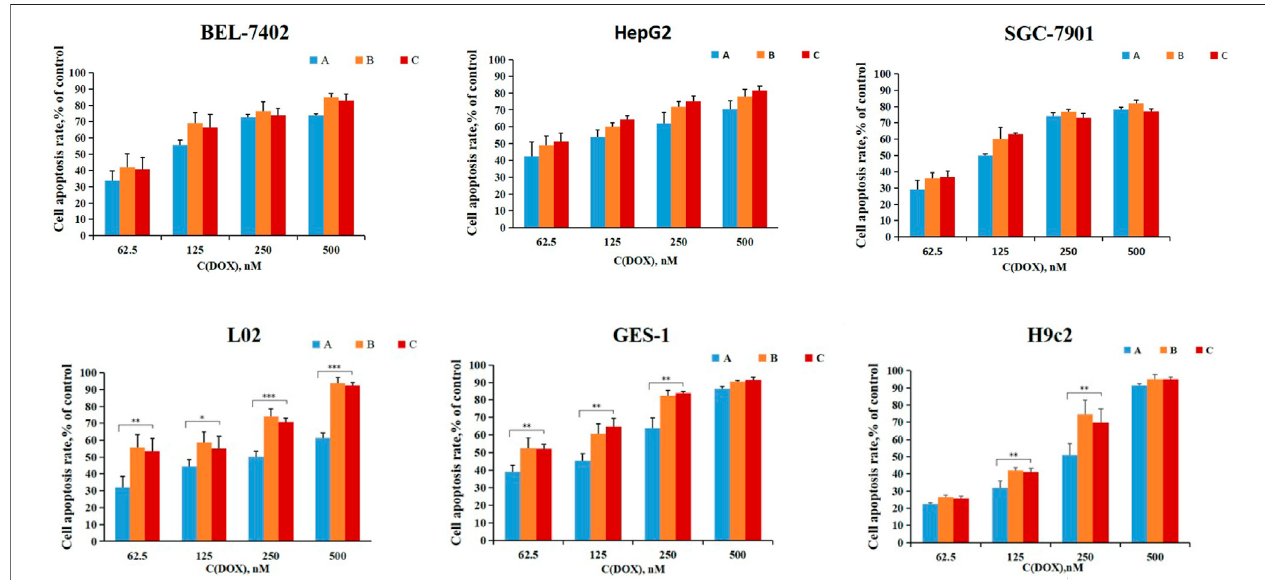
FIGURE 7 | In vitro cytotoxicity of micelles: DSPE-PEG-C60: DOX = 10:1 (W/W) (A), DSPE-PEG-NH 2 : DOX = 10:1 (W/W) (B), and free DOX (C) for 72 h for the determination of cell death using CCK-8 assays. Data represent the mean ± SD from three independent experiments (* p < 0.05, ** p < 0.01 and *** p < 0.001).